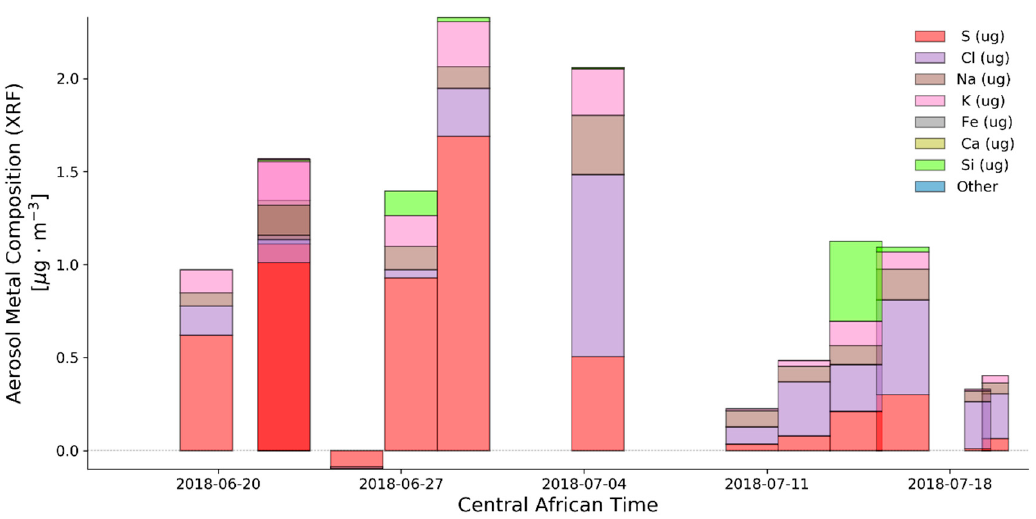
Figure 5. X-Ray Fluorescence analysis results from filter samples; colors for important species correspond to related ions in IC results in Figure 4. Values below the zero line indicate that there was no mass on the filter above the detection limit.